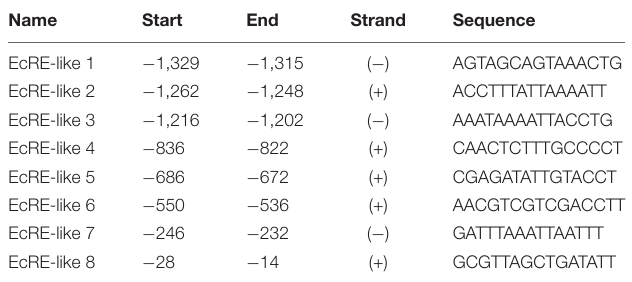
TABLE 2 | The predicted ecdysone response elements (EcREs) on the Bombyx mori ERR (BmERR)